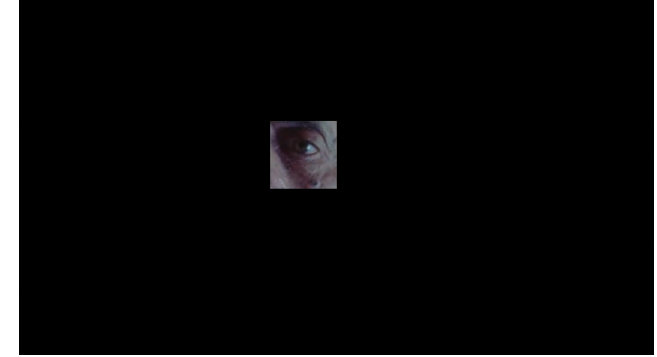
Figure 4 – Still from Once Upon a Time in America (1984), by Sergio Leone.